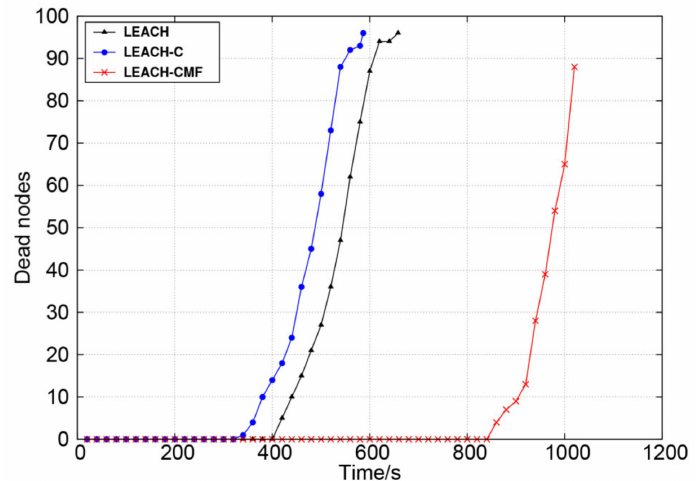
Figure 9. Changes in the number of dead nodes over time.